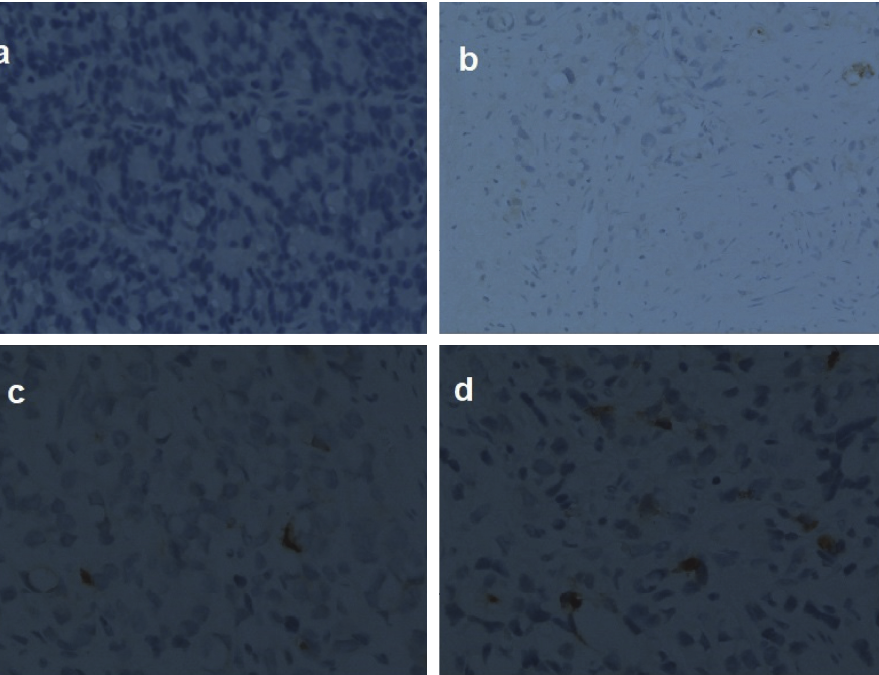
Figure 1: Immunohistochemistry staining using the primary antibody against lipocalin-2: (a) negative, 400x; (b) weak, 200x; (c) moderate, 400x; (d) strong expression,